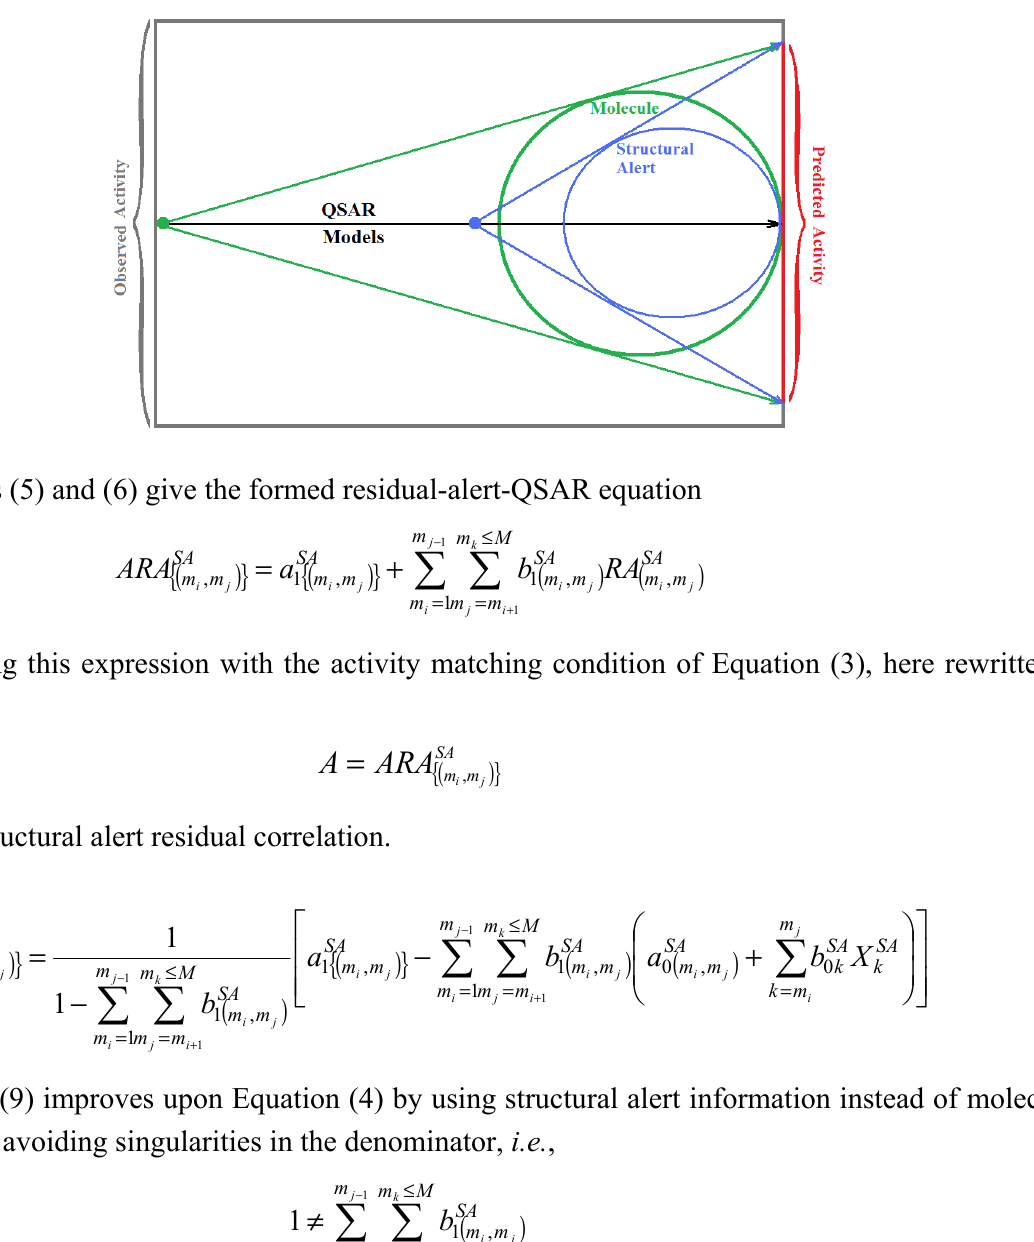
Figure 1. The alert-QSAR method uses structural alerts to assemble a molecular fragment QSAR model that has predictive power similar to that of full molecular